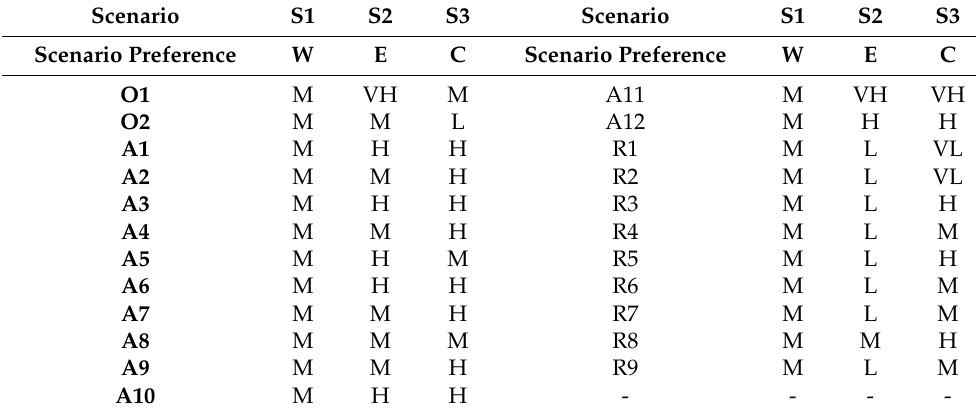
Table 4. Spatiotemporal fuzzy classes of all the